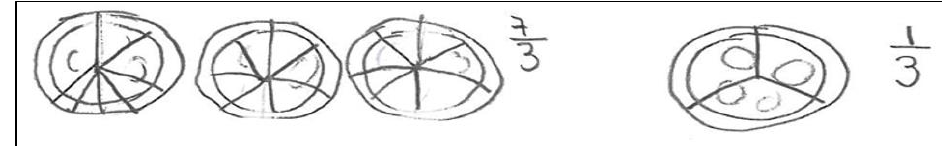
Figure 4. Examples of incomplete between strategy.